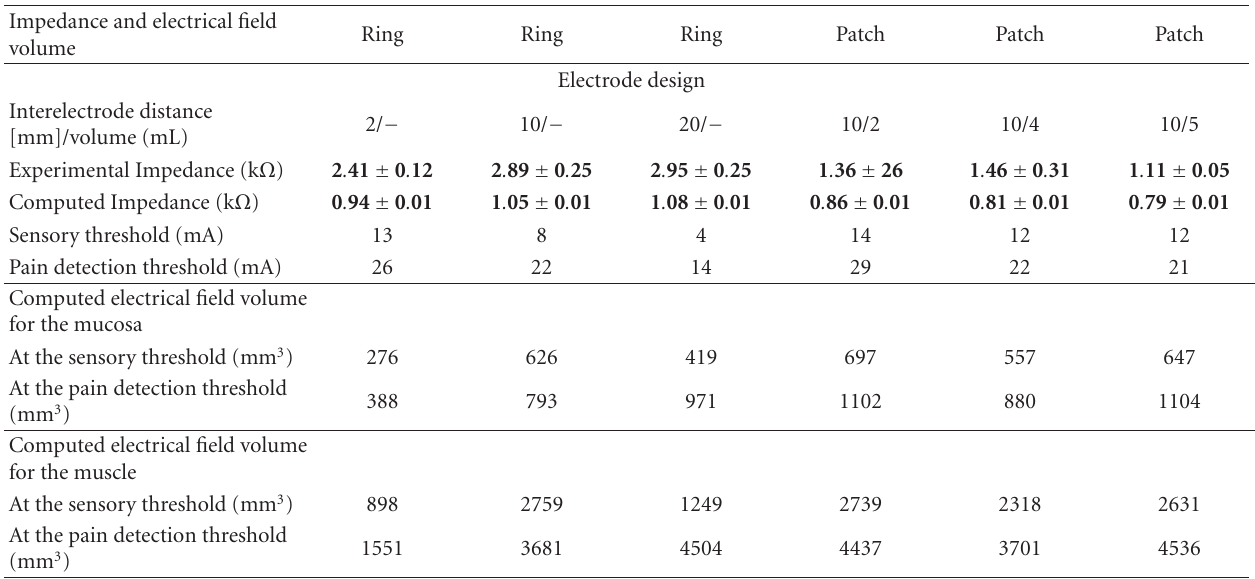
Table 1: For simplicity and as a first approach, the model assumed isotropic